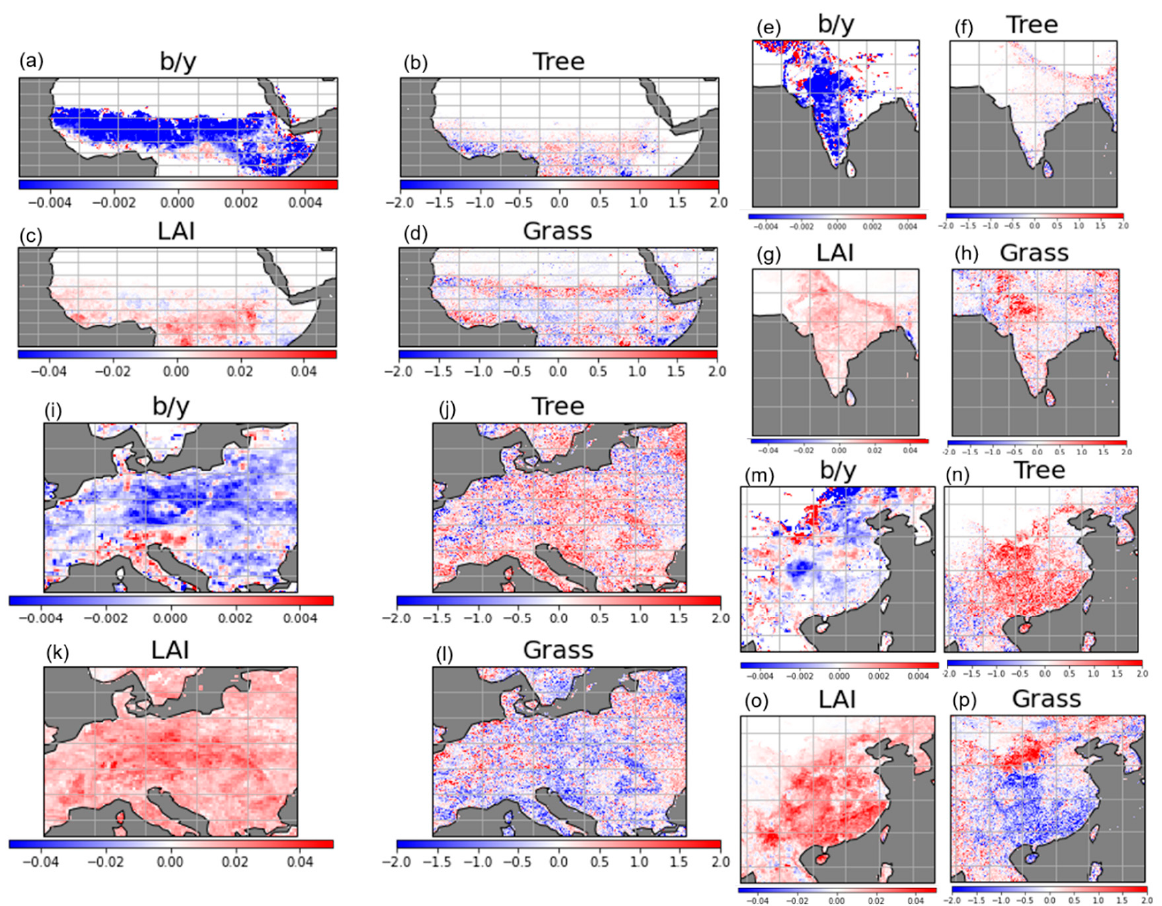
Figure 6. Linear trend of ( a , e , i , m ) b/y, ( b , f , j , n ) fraction of tree canopy, ( c , g , k , o ) LAI, ( d , h , l , p ) fraction of short vegetation, from 2003 to 2016 in ( a – d ) Sahel, ( e – h ) India, ( i – l ) Europe, and ( m – p ) East Asia. The long-term trends of the VCF data and our b/y index are consistent (Figure 7).